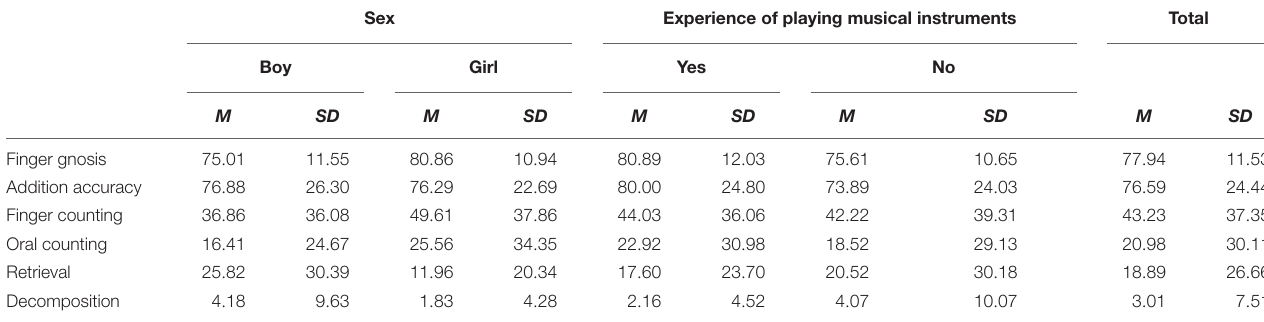
TABLE 1 | Descriptive statistics in Study 1.